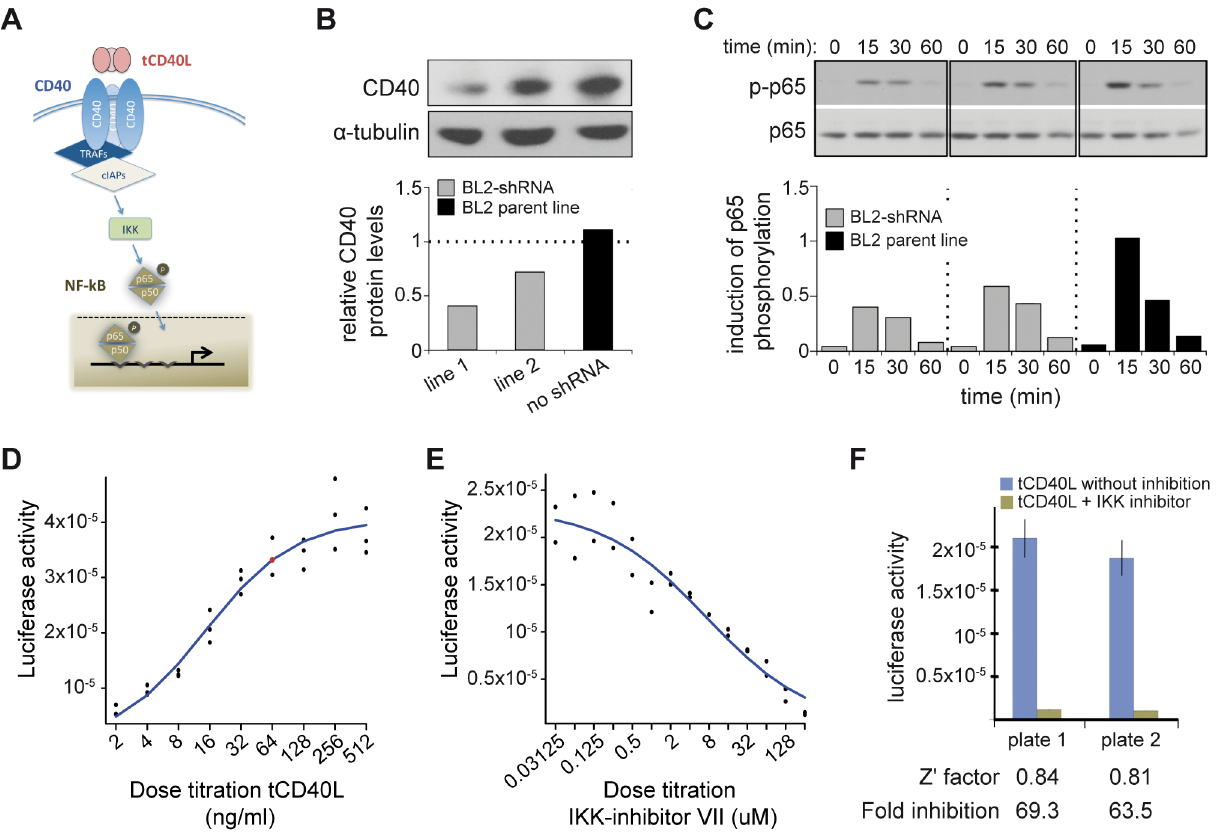
Figure 2. CD40 knockdown and CD40-luciferase assay in BL2 cells. (A) Schematic of the canonical CD40 – NF-|B signaling pathway in B cells. (B) RNAi perturbation of CD40 in two distinct clones derived from BL2 cells decreases CD40 protein levels by 55% (left) and 40% (middle) compared to the BL2 parent line (black, right); (C) More CD40 on the surface of BL2 cells increases RelA (p65) phosphorylation following activation with tCD40L, as measured by Western blot, with maximum activation at 15 minutes. Results are shown for the same two shRNA lines and parental BL2 cell line as in (B). This is a representative example of multiple experiments. (D) Titration of tCD40L leads to increased luciferase activity. Each experiment was performed in triplicate. The red circle represents , 80% maximum luciferase activity (64 ng/ml tCD40L). Luciferase activity at baseline (i.e., no tCD40L activation) was subtracted from each measurement to plot results. (E) Titration of IKK inhibitor VII leads to inhibition of luciferase activity following tCD40L activation. Each experiment was performed in duplicate. (F) The luciferase assay is robust, with Z’-factor . 0.80 and . 60-fold inhibition of luciferase activity without killing cells across different plates.